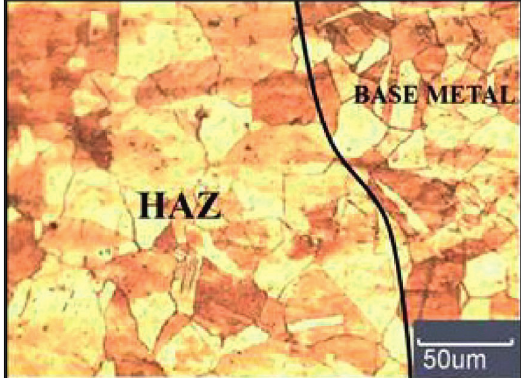
Figure 15: Optical micrograph representing HAZ/base metal